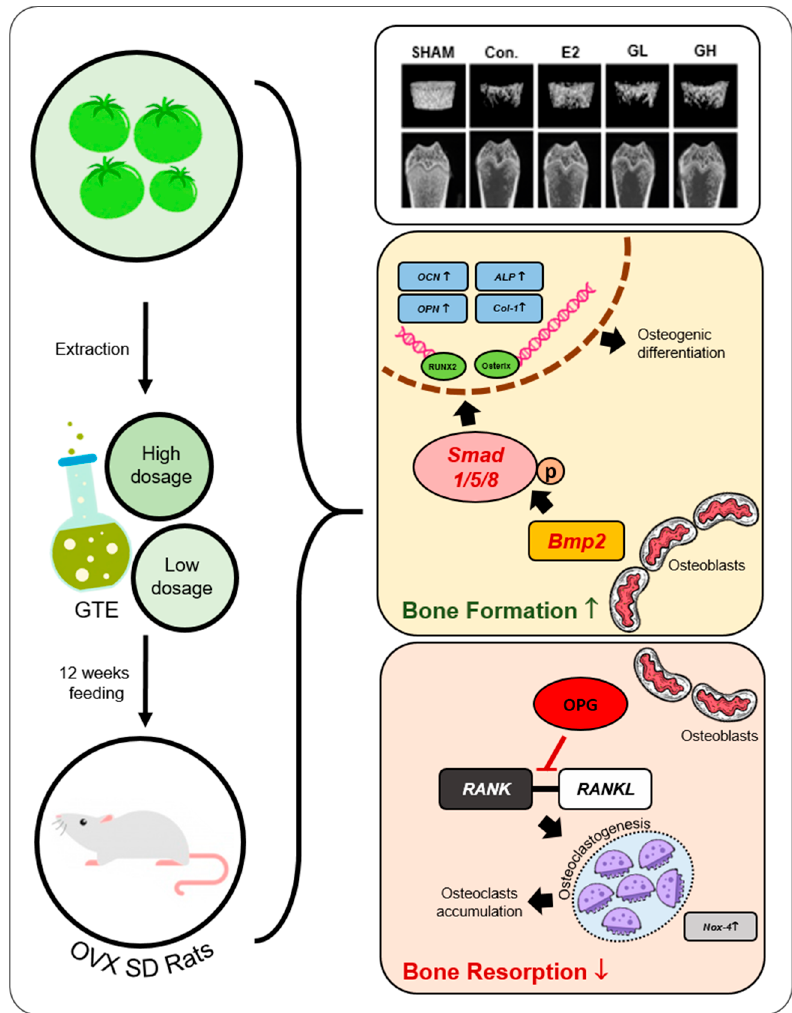
Figure 7. Schematic diagram for the effect GTE supplementation on the prevention of postmenopausal osteoporosis.